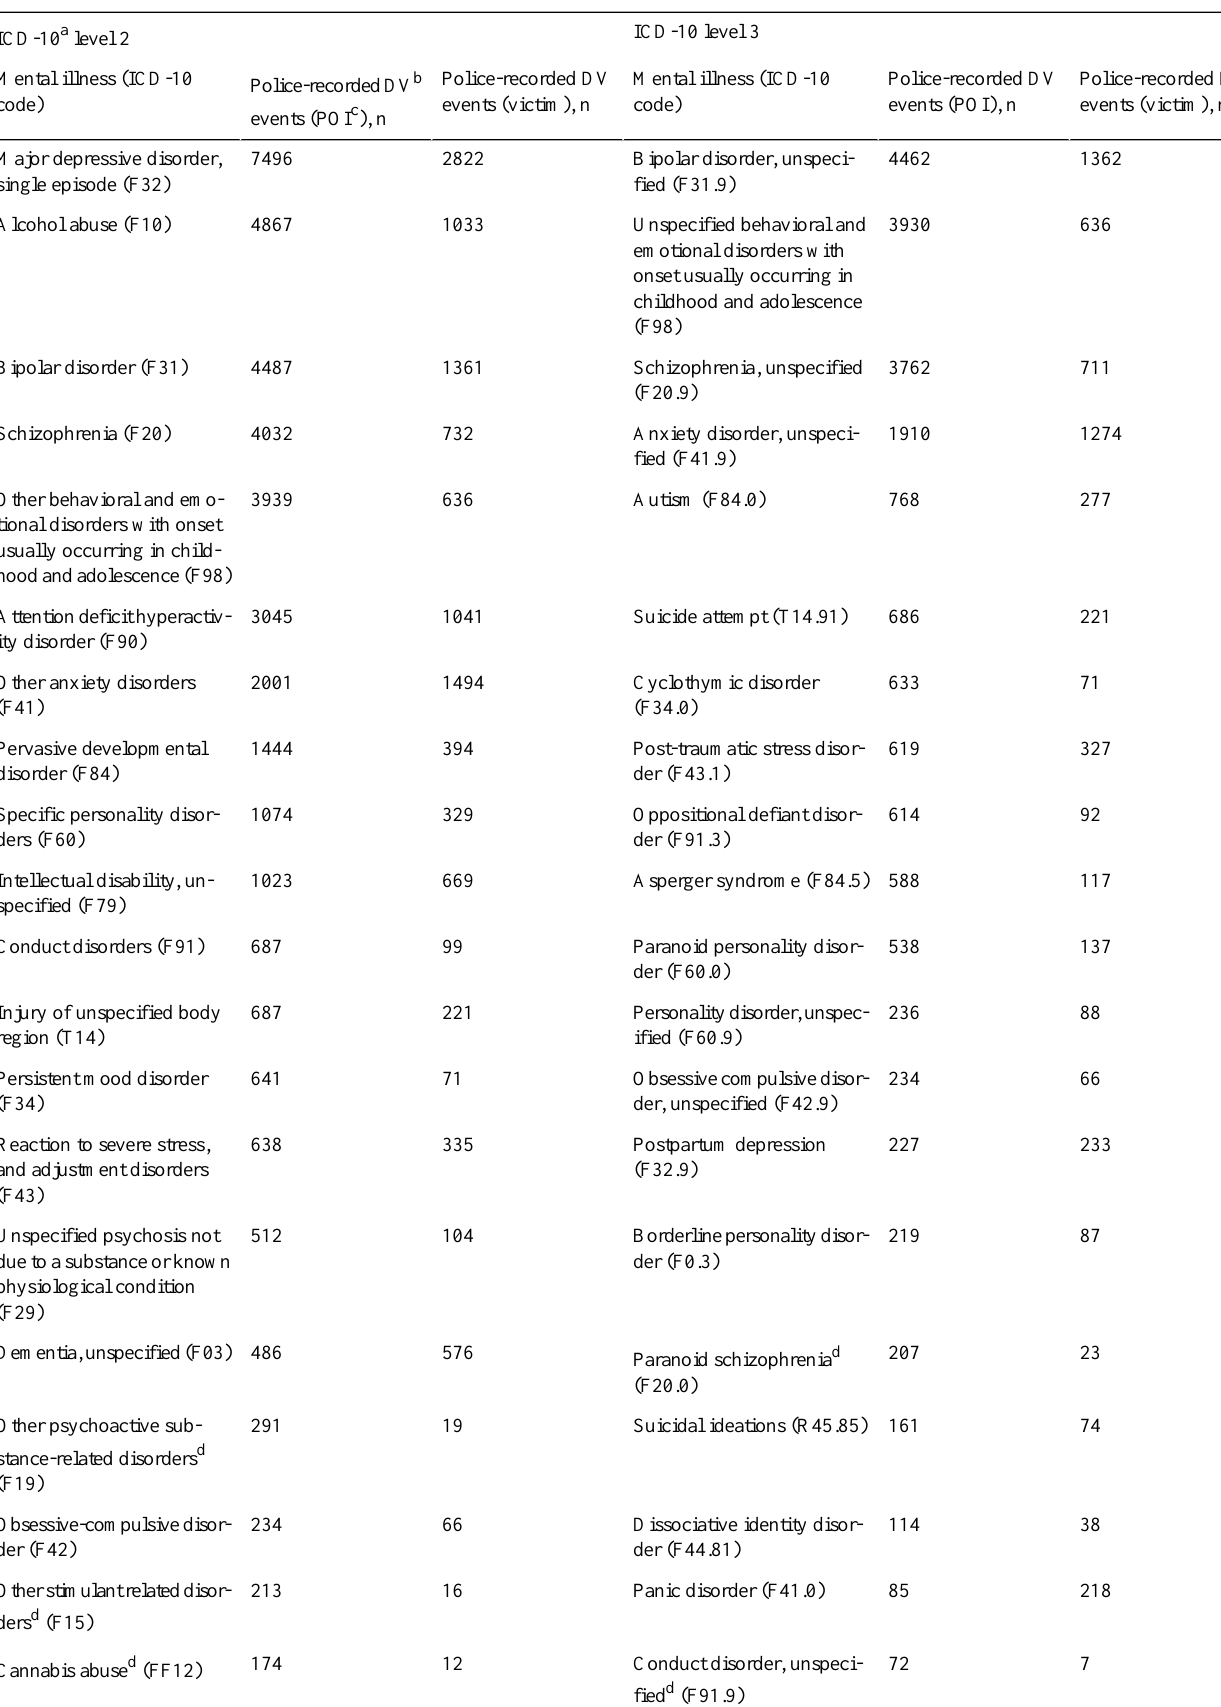
Table 3. The 20 most commonly reported mental illnesses for both POIs and victims (at the second and third level of the ICD-10 categories) in 416,441 DV events recorded by the New South Wales Police Force in Australia between 2005 and